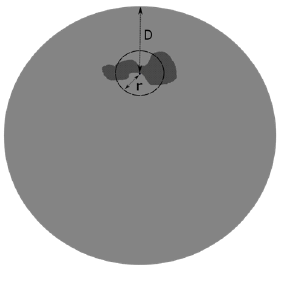
Figure 2. Equivalent defect of radius r at a distance D from the outer